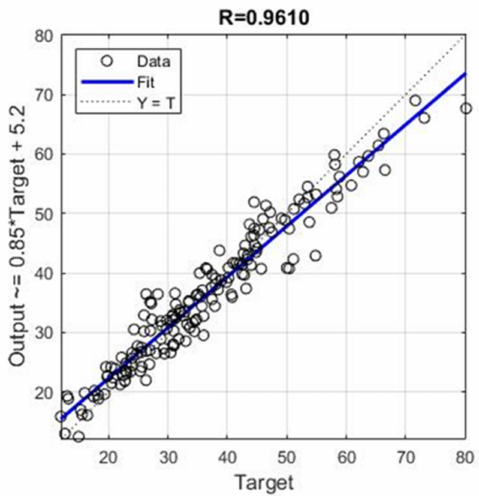
Figure 10. Prediction of individual neural networks (yellow color), ensemble model prediction (dark blue color) and target values (red color) of compressive strength.